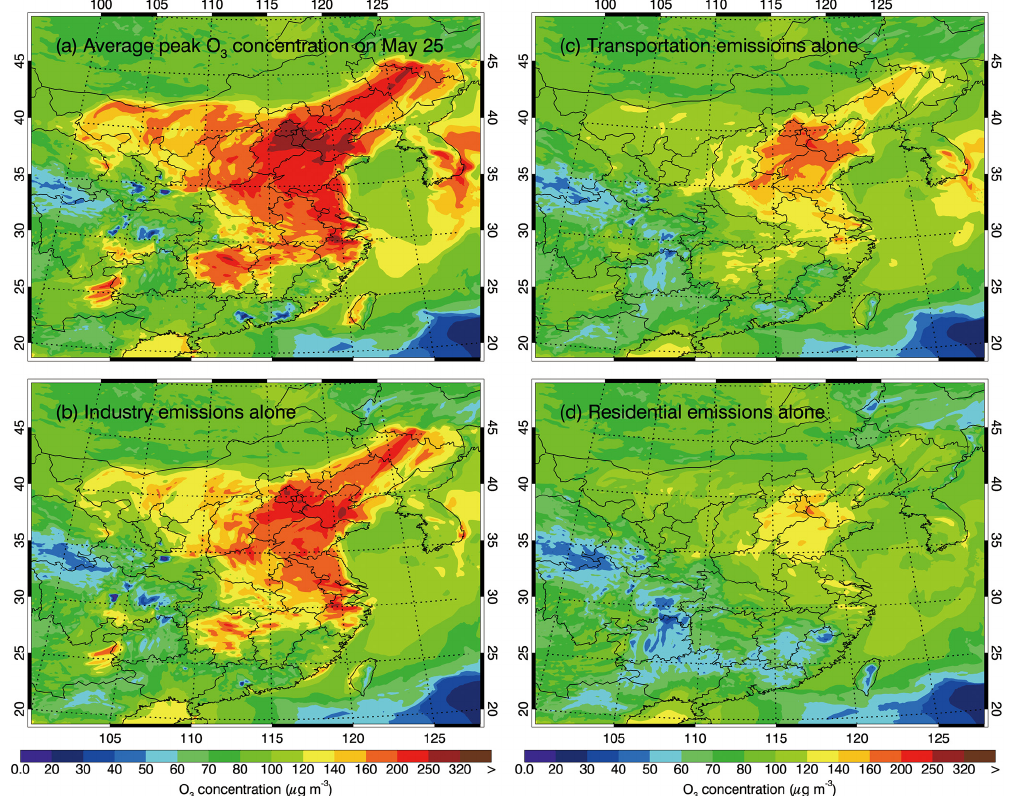
Figure 11. Distributions of the average O 3 concentration during peak time with (a) all anthropogenic emissions, (b) industry emissions alone, (c) residential emissions alone, and (d) transportation emissions alone on May